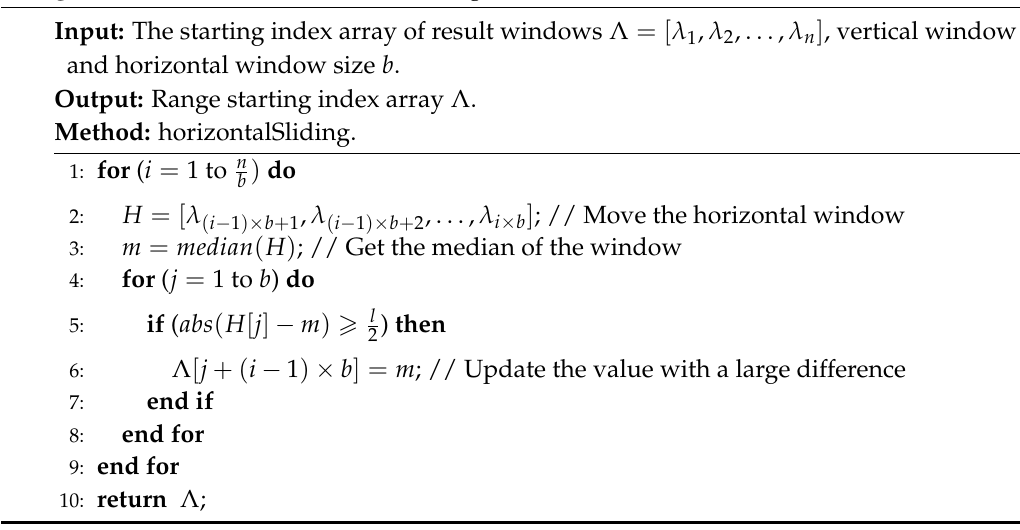
Algorithm 2: Horizontal Window